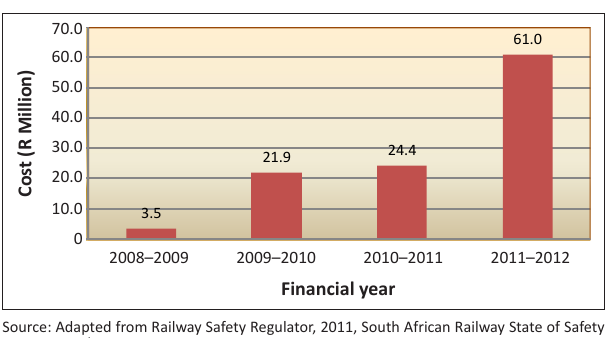
FIGURE 2: PRASA: Costs incurred with respect to